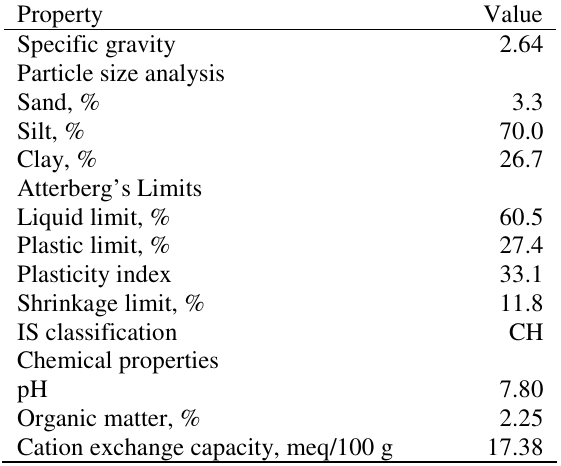
Table 1. Composition and relevant properties of soil used .